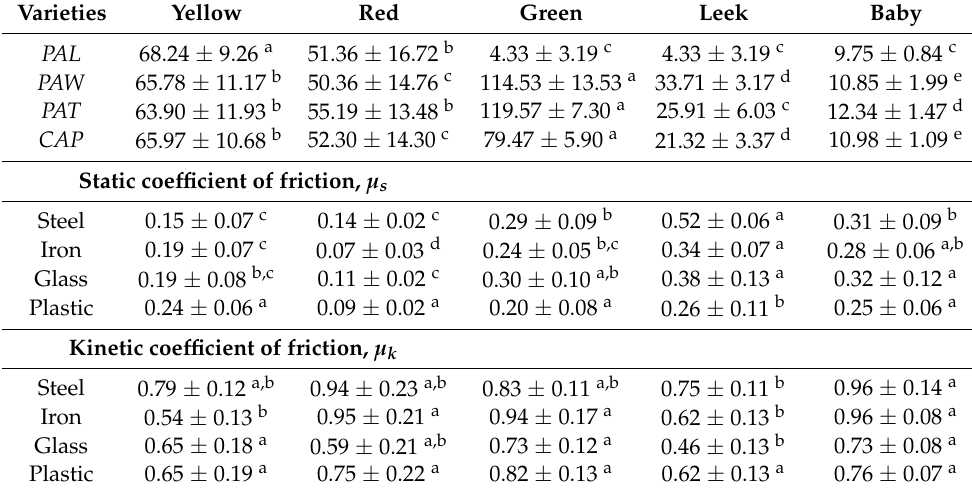
Table 3. Projected area and friction